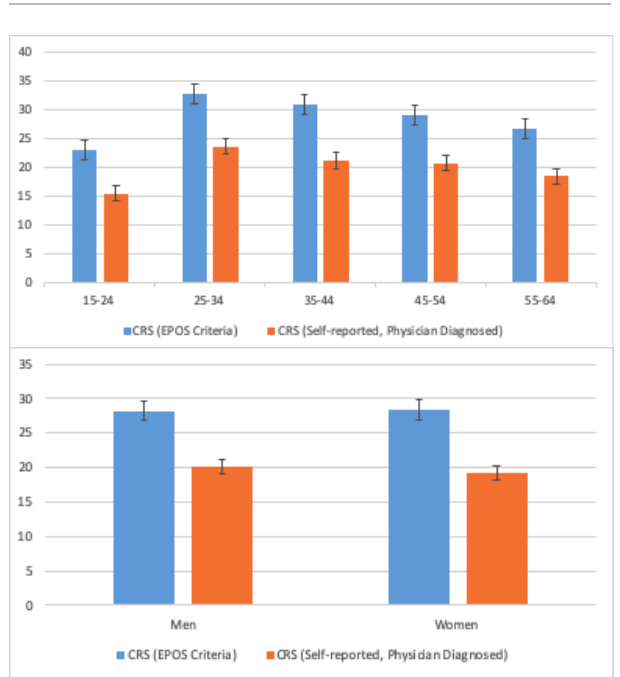
Figure 1. Comparison of the prevalence of CRS according to two meth- ods of definition by sex and age